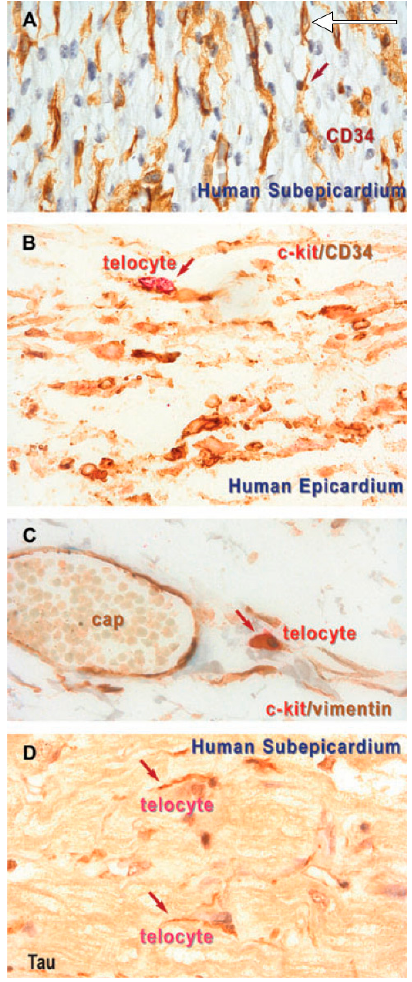
Figure 6. Reprinted with permission from John Wiley and Sons (License Number: 4562340930830) from [27]. The original legend in the *.pdf version of the article indicates “ Figure 3(A) Immunostaining for CD34 (brown). CD34 positivity might be expressed by telocytes and endothelial cells. (B) Localization of double positive cells for c-Kit (red) and CD34 (brown). (C) Human epicardium, deep layer. Vimentin positivity is stronger than c-Kit positivity by sandwich method. (D) Cells expressing τ protein (arrows). (A–D) Original